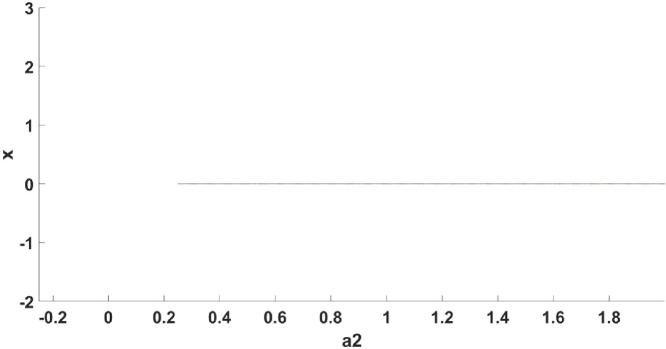
Bifurcation at situation 3.